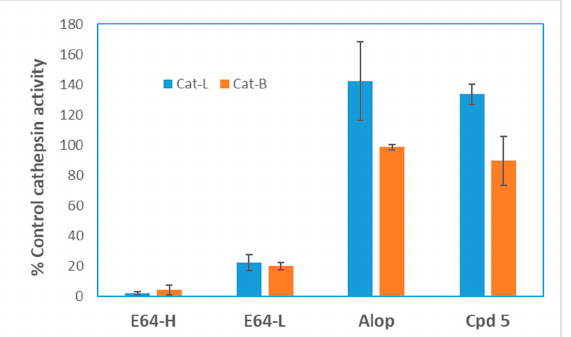
Figure 2. Aloperine derivatives were inactive against cathepsin B and L. Compound 5 and aloperine were tested for their inhibitory activity against cathepsin B or L using a BPS bioscience assay kit and the protocol provided by the manufacturer (catlog#79590). The enzyme activity in the absence of compounds (control) was defined as 100%. Aloperine (Alop) and compound 5 (Cpd 5) were tested at 20 µM. The known cathepsin B inhibitor E64 was tested at 0.1 µM (E64-H) and 0.01 µM (E64-L), respectively. The data represent the average of a duplicated experiment.